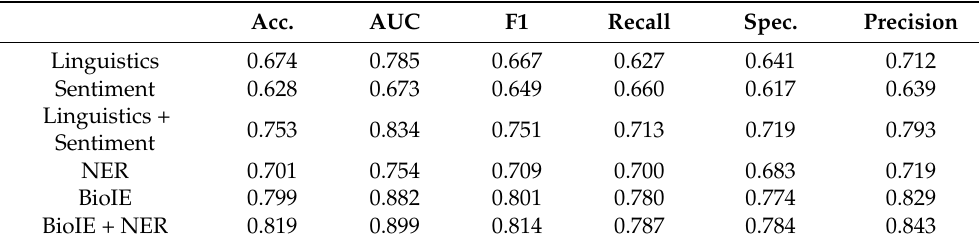
Table 9. Comparison of information features-based models with the model trained with linguistics and sentiment